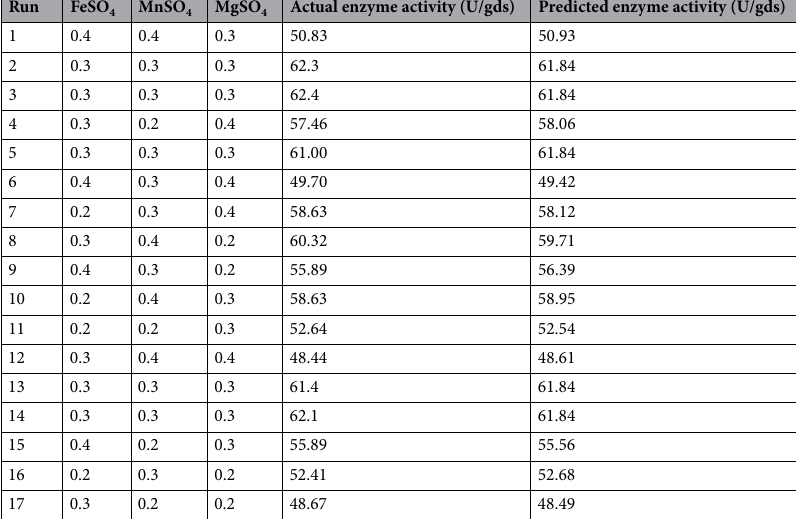
Table 4. Box Behnken design showing effect of various factors on pullulanase production.